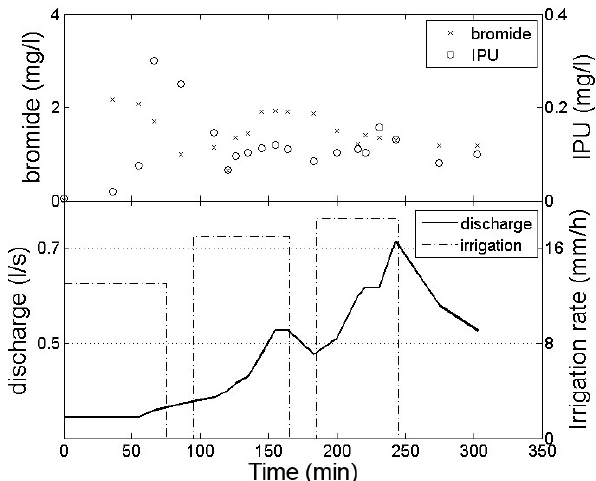
Fig. 1. The experimental results from the study of Zehe and Fl ¨ uhler (2001). The upper panel presents the bromide and Isoproturon (IPU) concentrations, while the lower panel presents the tile drain discharge and the irrigation